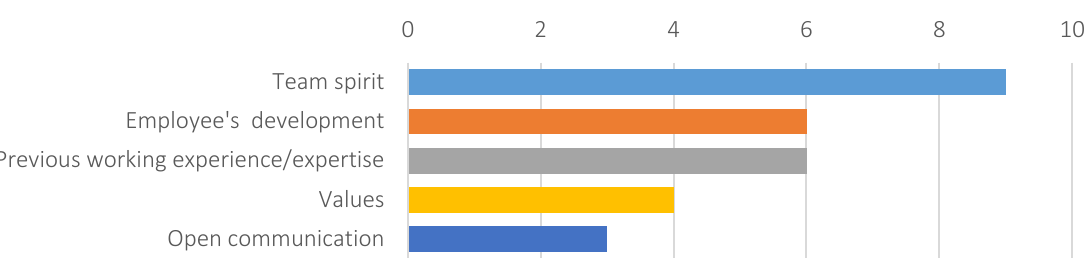
Figure 3b. Internal marketing and promotion of the desired behavior/coding